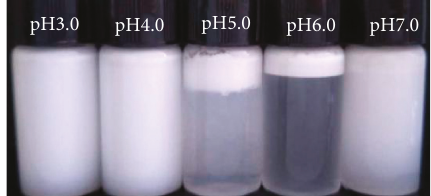
Figure 2: Photographs of BSA-stabilized emulsions (containing 0.15% w/v BSA and 5% v/v oil with different pH values) after 20-day storage at 25 °